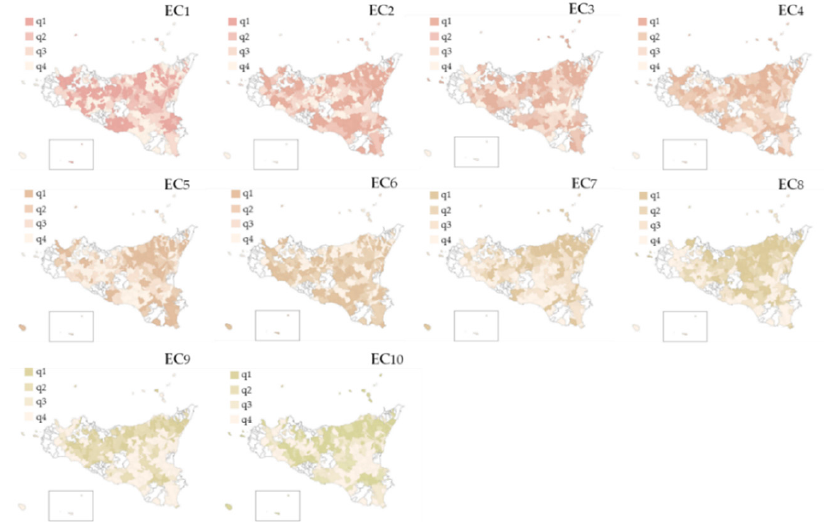
Figure 11. Mapping Economic Capital Indicators. (Authors’ elaboration.)